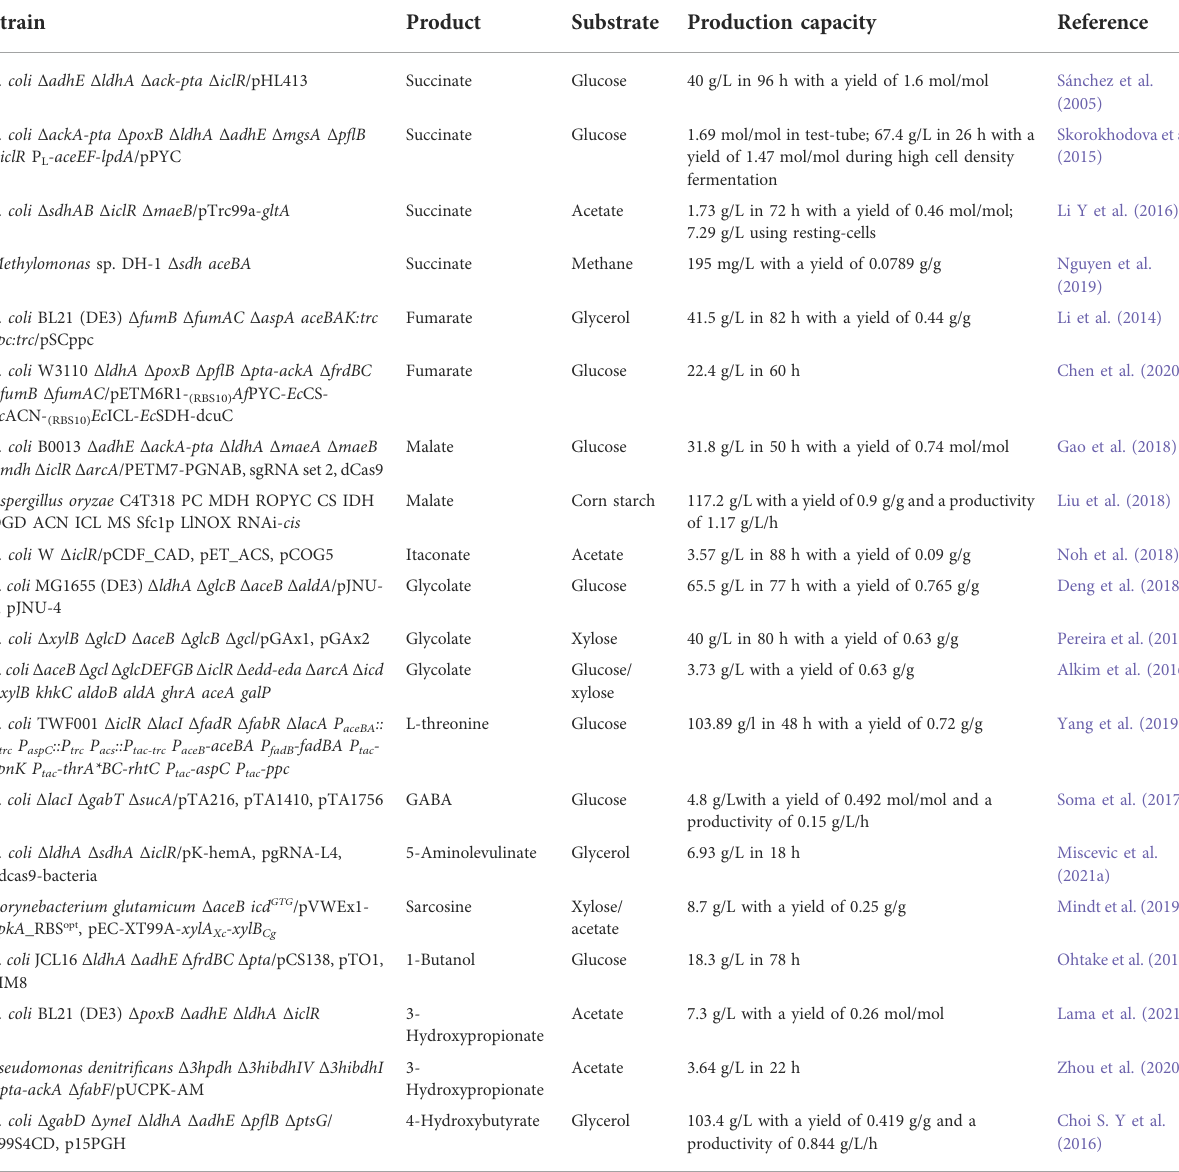
TABLE 1 Representative studies of chemical biosynthesis through GS engineering.